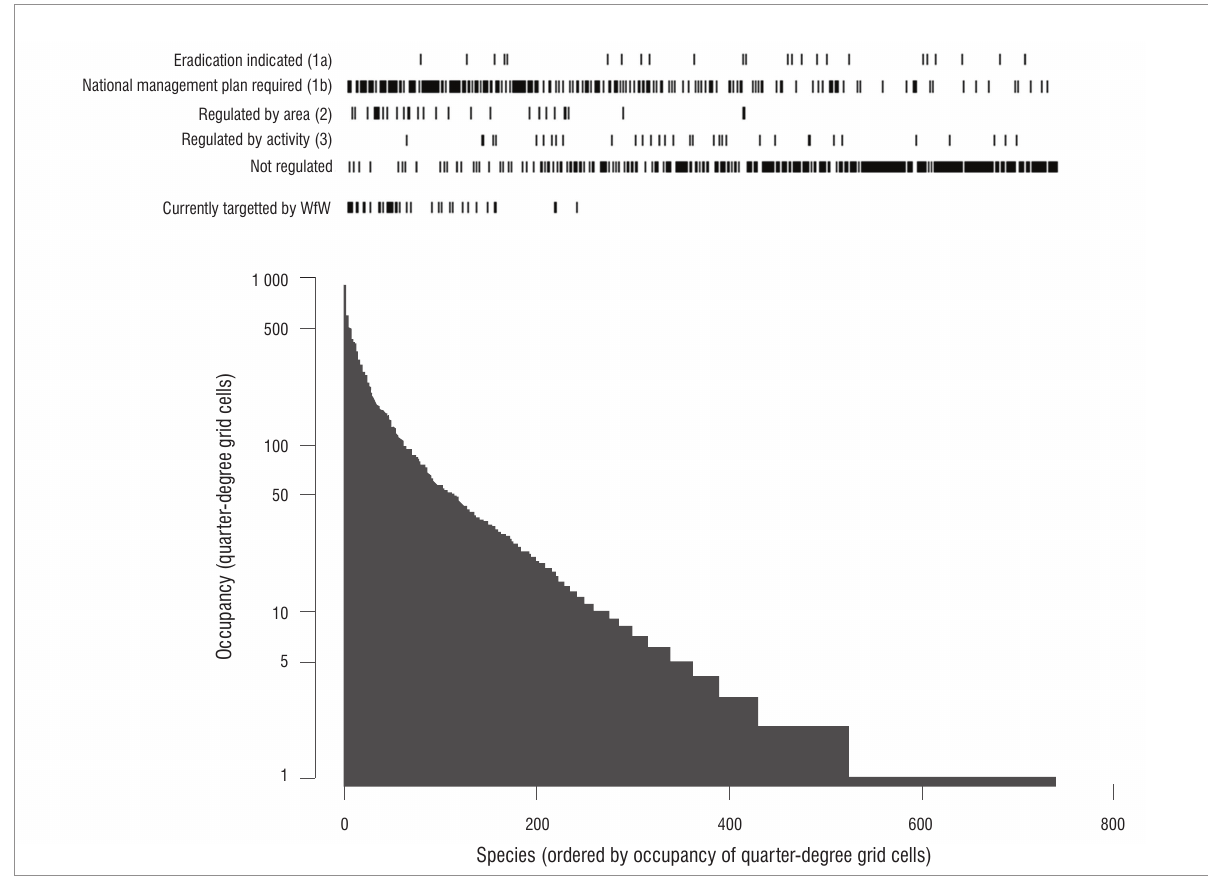
Species (ordered by occupancy of quarter-degree grid cells)